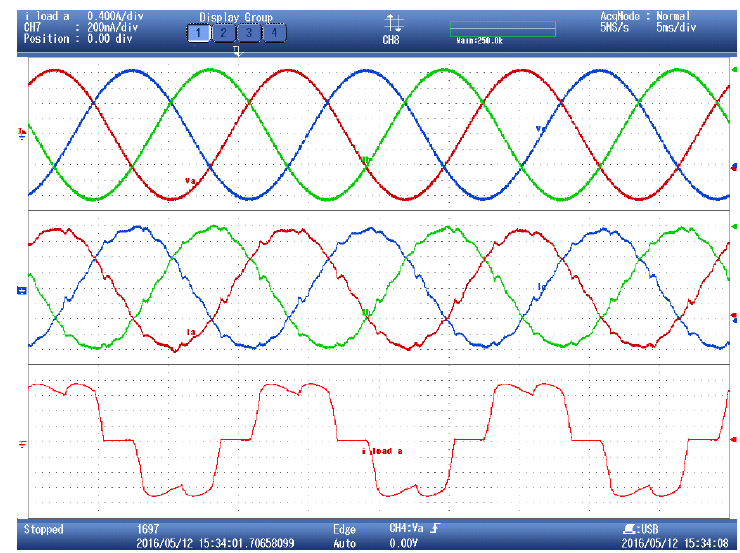
Figure 20. Three phase voltages, three-phase grid currents compensated and initial polluted current load in phase a .